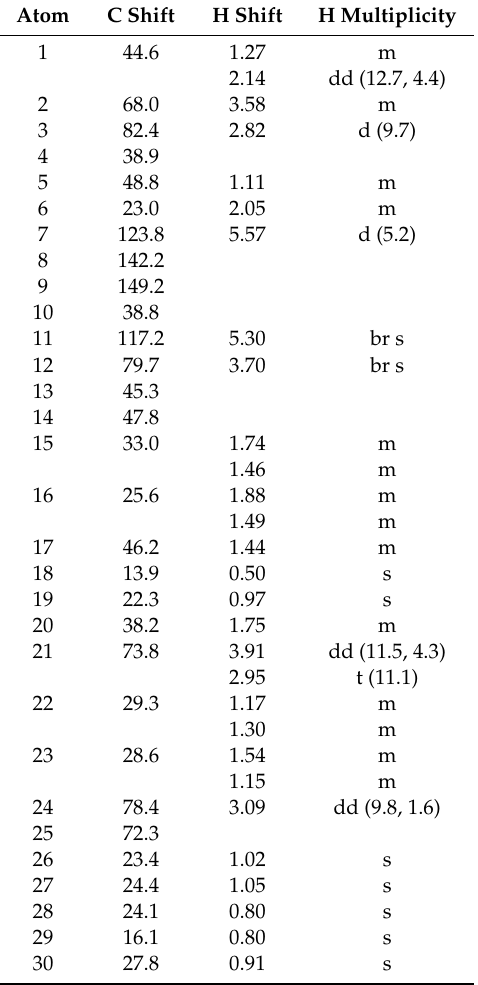
Table 1. The 1 H and 13 C-NMR assignments of compound